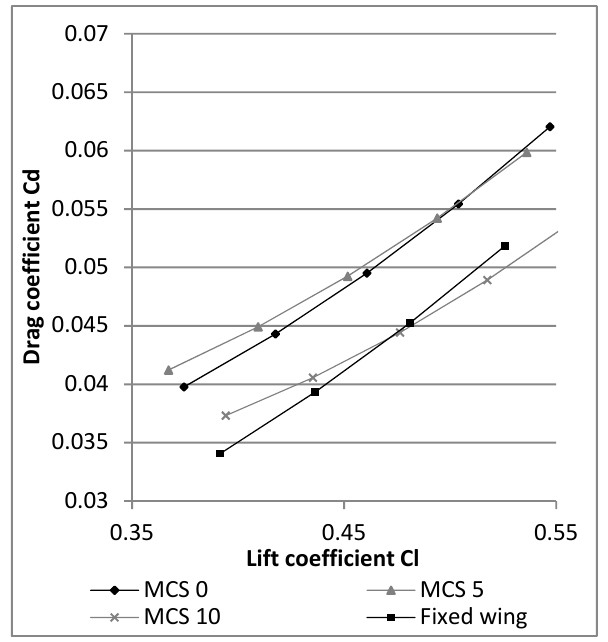
ffi cient variation with lift coe ffi cient for UAS-S4 Figure 29 Drag coefficient variation with lift coefficient for UAS-S4 (zoom). Figure 29. Drag coe